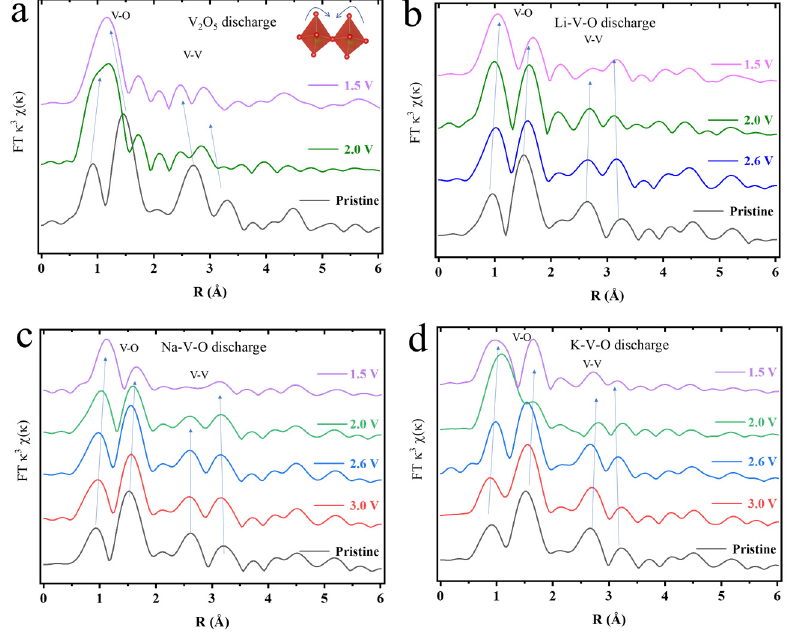
Figure 4. Ex situ V K-edge EXAFS of the discharge process for V 2 O 5 ( a ), Li-V-O ( b ), Na-V-O ( c ) and Figure 4 . Ex situ V K-edge EXAFS (b, d, f) of the discharge process for V 2 O 5 (a), Li-V-O (b), Na-V-O 270 K-V-O ( d ) at different electrochemical (c) and K-V-O (d) at different electrochemical states.